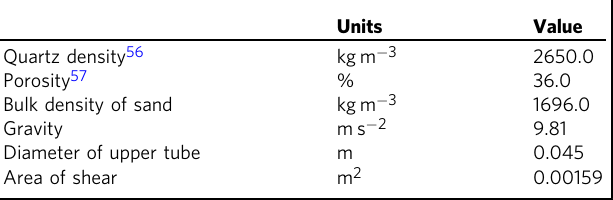
Table 1 Values used to calculate the sand material parameters.